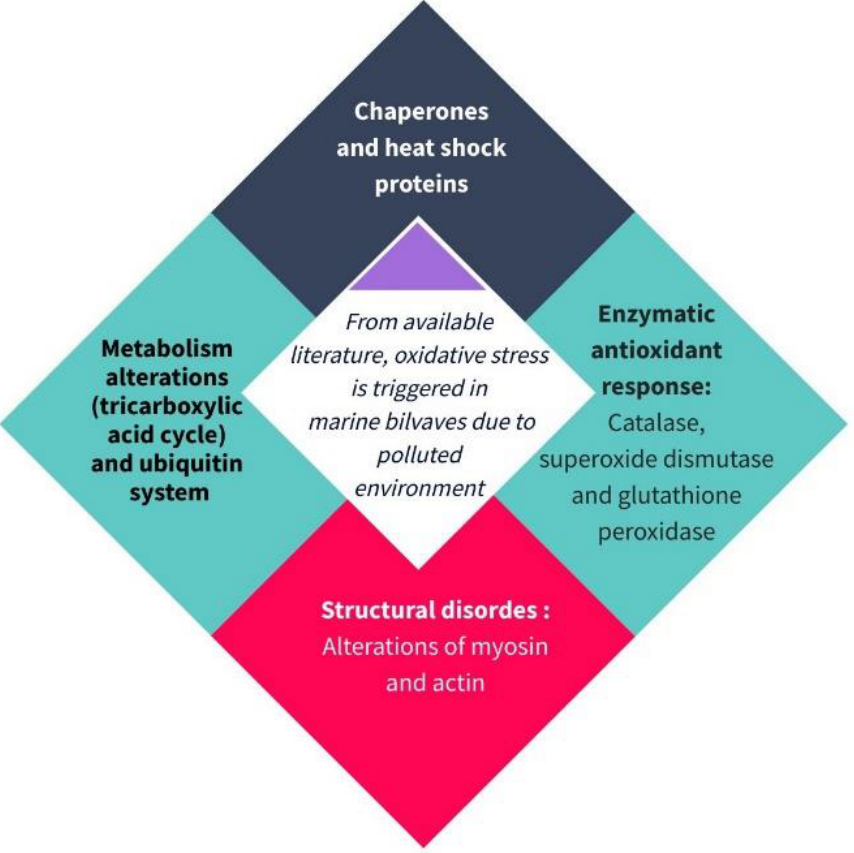
Figure 5. Pollution biomarkers of marine bivalves can be classified into four groups: chaperones and heat shock proteins, proteins involved in metabolism alterations and ubiquitin system, enzymes from the antioxidant response, and structural proteins.